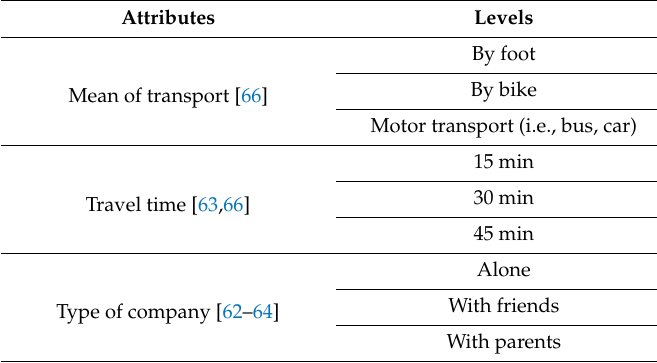
Table 1. Attributes and levels of the